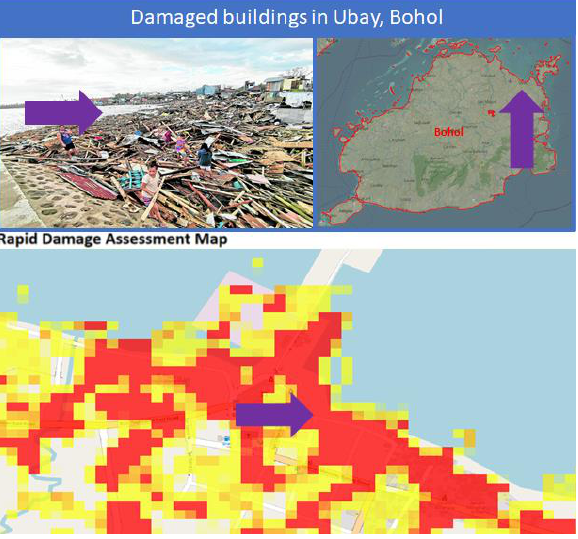
Figure 10. Good correspondence can be seen between the ground photo and the SAR-derived rapid damage assessment map at Ubay, Bohol. Photo © Inquirer.net, 2022. Basemap © OSM 2022.